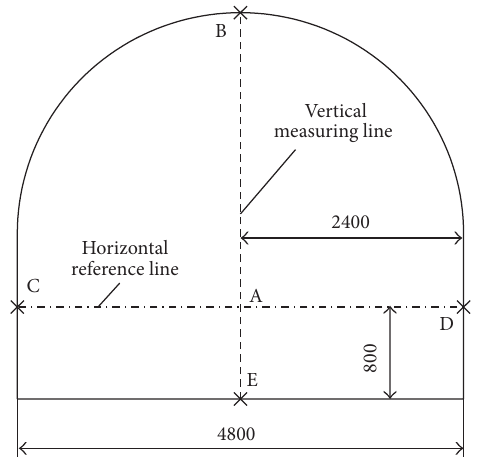
Figure 12: Monitoring sites for the deformation of the roadway.